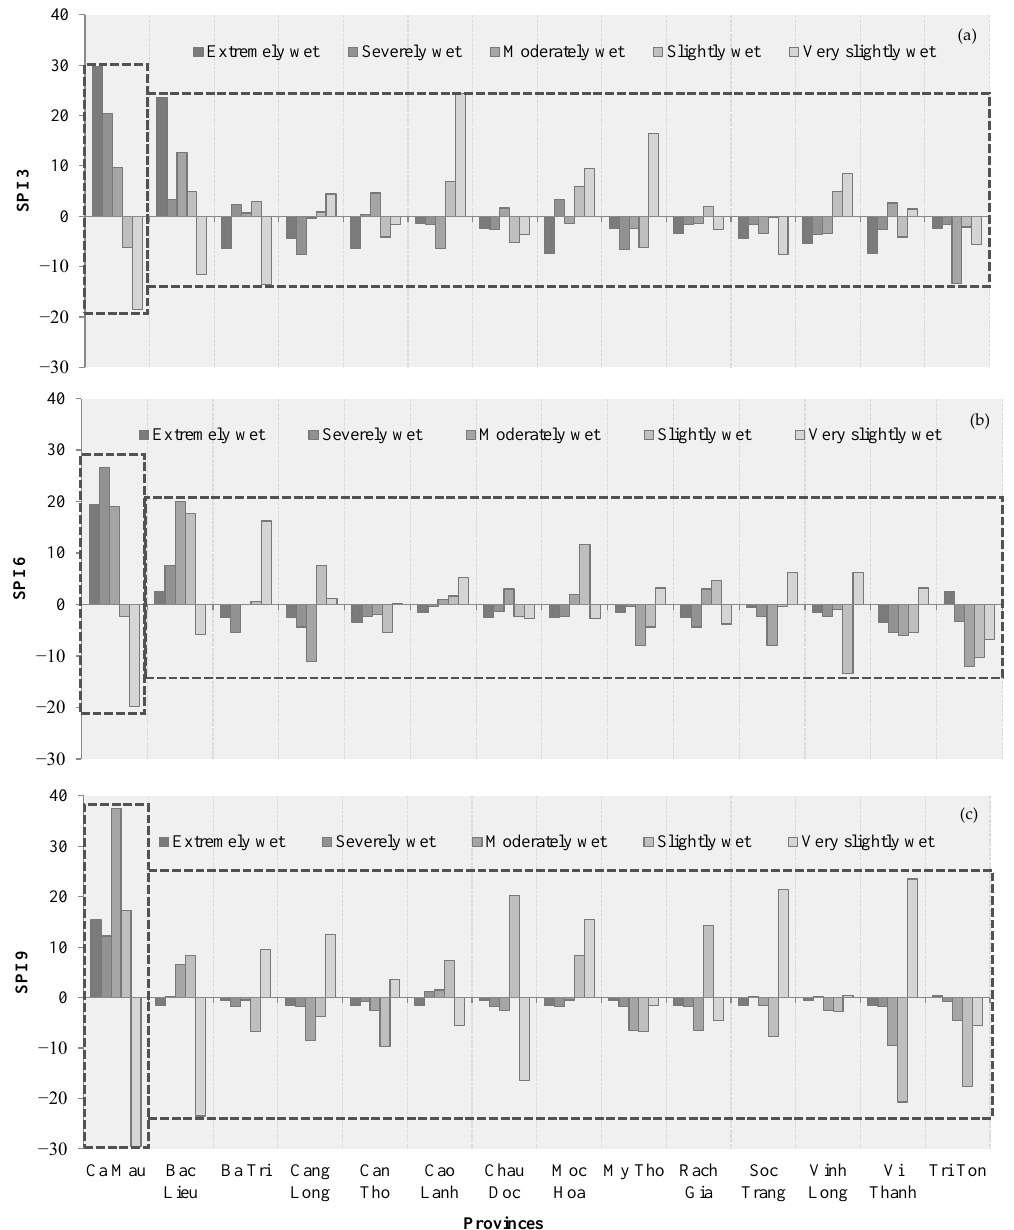
Figure A1. Number of occurrence events of various wet conditions at SPI 3 ( a ), SPI 6 ( b ), and SPI 9 ( c ) over 14 meteorological stations in the VMD.